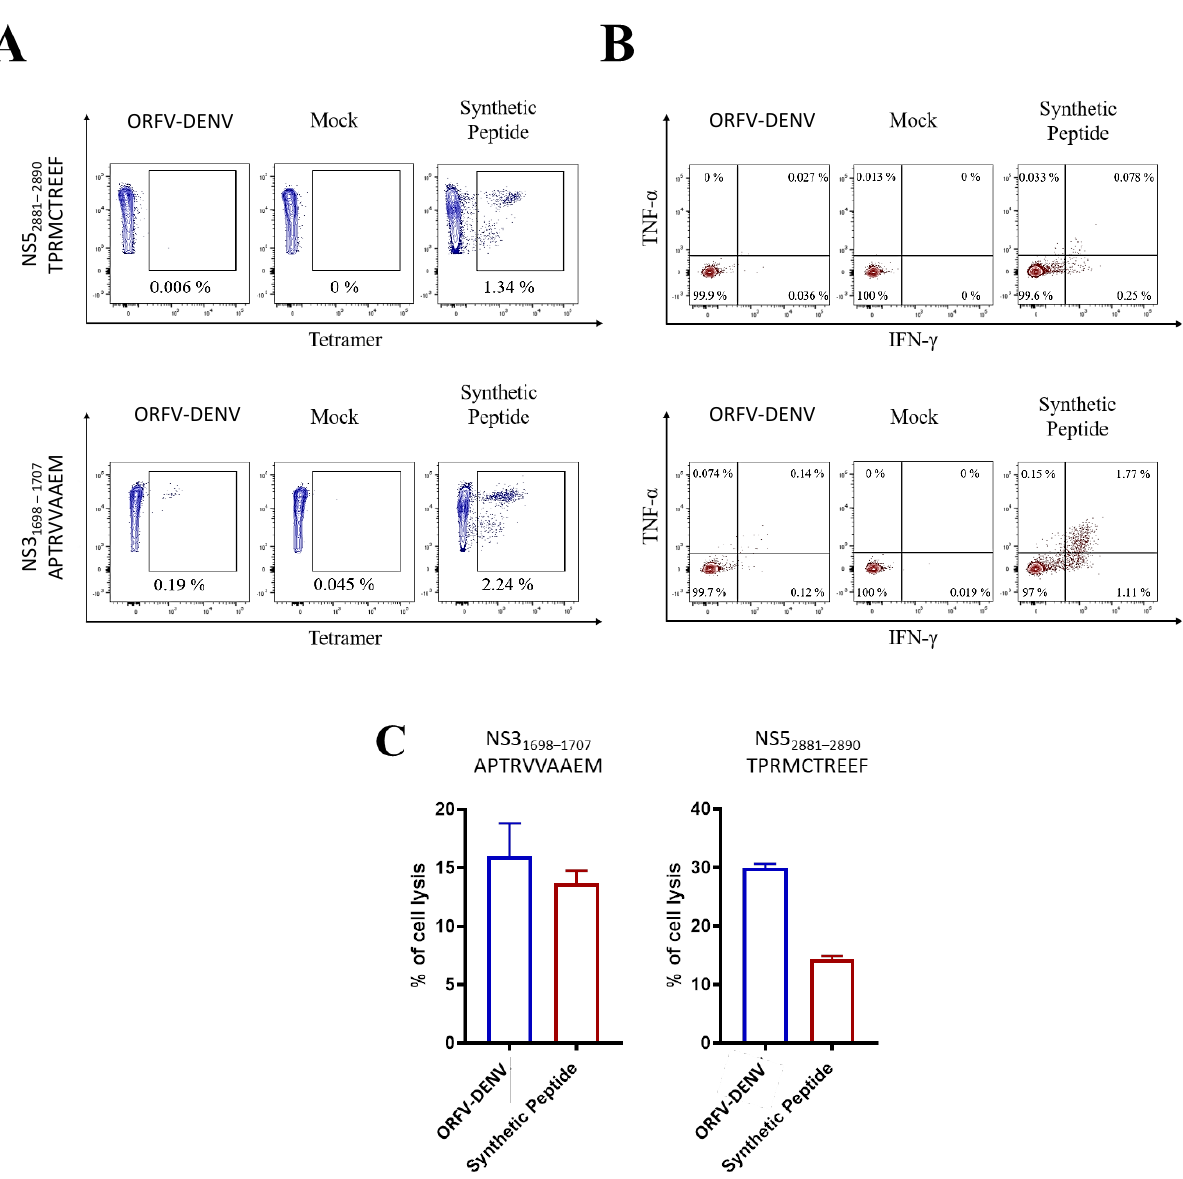
Figure 5. Cross-reactive CD8 + T cell responses in PBMCs from confirmed ZIKV-positive donor DENV-021 after in vitro restimulation with ORFV-DENV expressing DENV-derived peptide epitopes. Frequencies and functionality of epitope- specific CD8 + T cells were determined by ( A ) HLA tetramer staining, ( B ) ICS, and ( C ) specific lysis after 20 h of co-incubation with peptide-pulsed target cells at an effector-to-target ratio of 0.1:1. The percentage of target cell lysis corrected for spontaneous background lysis is shown. A synthetic peptide was used as a